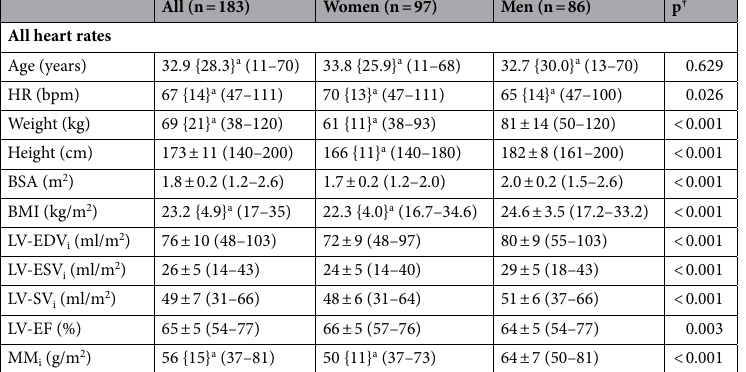
Table 1. Baseline characteristics of healthy participants. Normally distributed values were expressed as mean ± standard deviation, otherwise as median ( a ) with interquartile range. Ranges in parentheses. † p-value related to gender. Normally distributed data were tested by the unpaired t-test, otherwise with the Mann– Whitney-U-test. BSA body surface area, BMI body mass index, LV-EDV i BSA-indexed end-diastolic